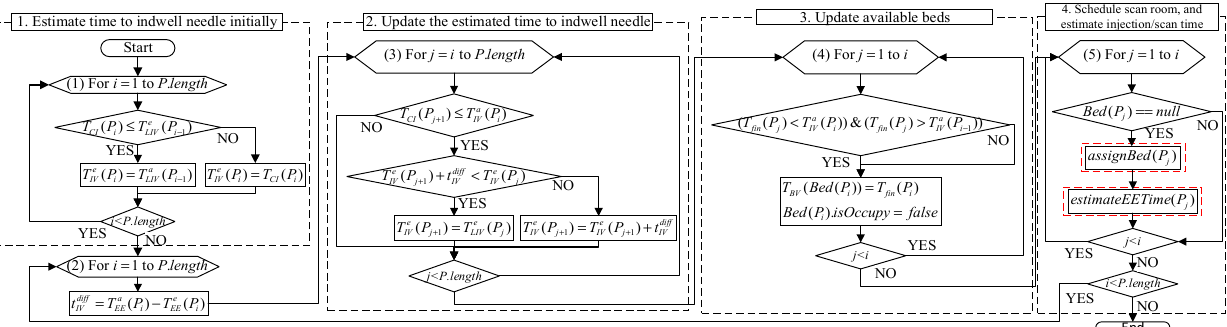
Figure 16. Experimental group data output flow chart.